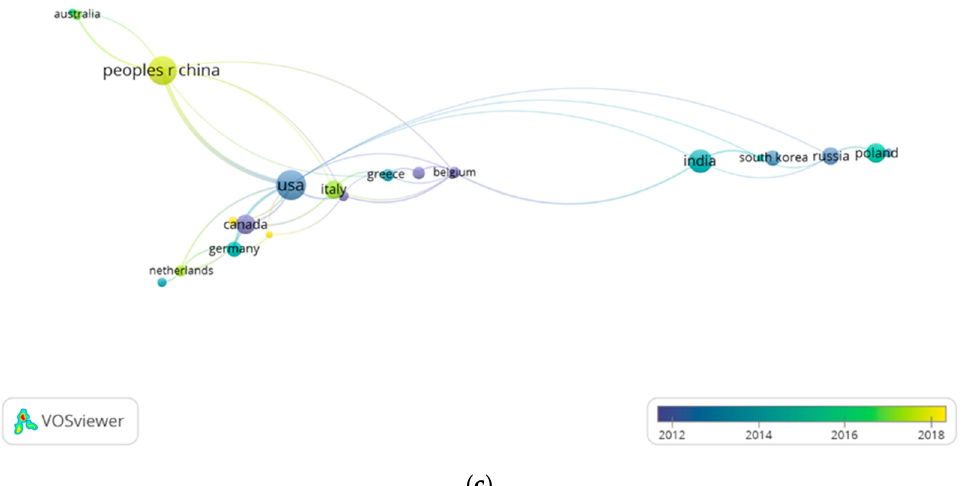
Figure 3. ( a ). Collaborative network analysis of authors in biodegradation-of-plastics-related research between 2000 and 2021. ( b ). Collaborative network analysis of institutions in biodegradation-of-plastics-related research between 2000 and 2021. ( c ). Collaborative network analysis of countries in biodegradation-of-plastics-related research between 2000 and 2021.